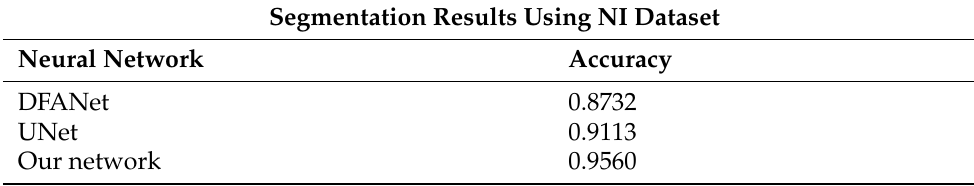
Table 8. Defect segmentation results using DFANet and UNet on NI